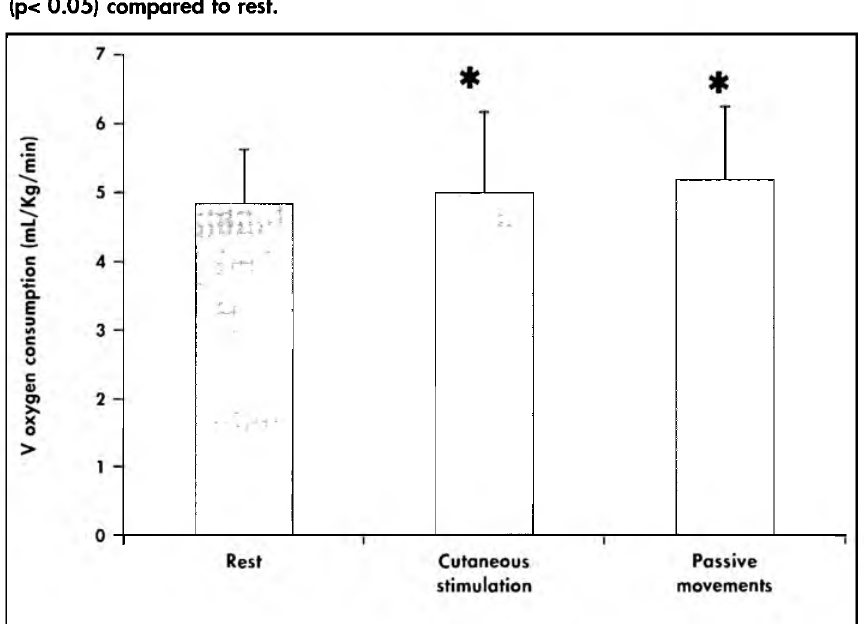
FIGURE 4. Mean and standard deviation of Oxygen Consumption at rest, during cutaneous stimulation and passive movements (n=60), * indicates significant difference (p< 0.05) compared to